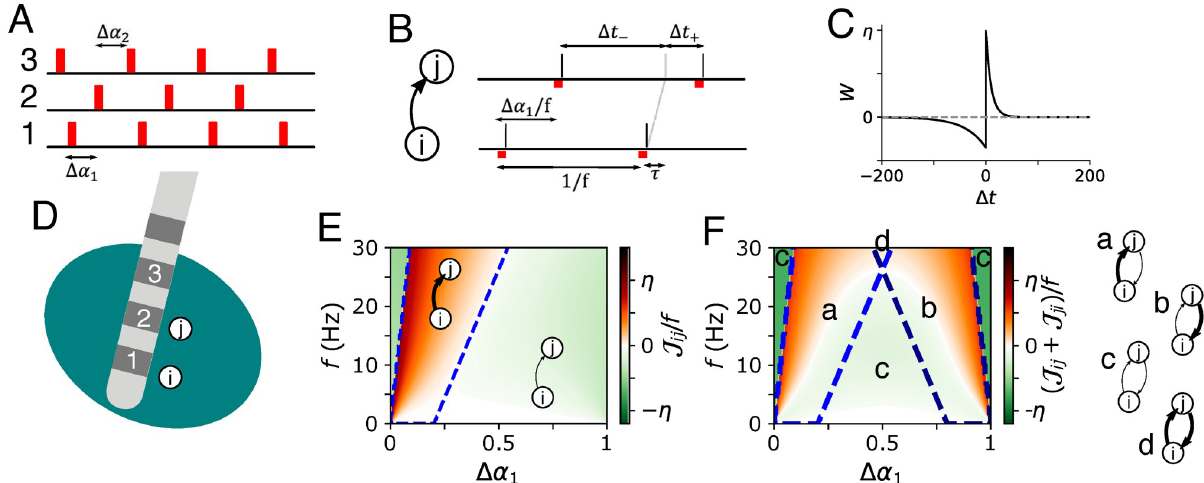
Fig 1. Reshaping of synaptic connectivity by PMCS. A: During PMCS, periodic stimulus trains (red) are delivered to multiple neuronal subpopulations (1,2,3) with phase shifts ( Δ α 1 , Δ α 2 ). D: Schematic of PMCS delivery using a multisite DBS electrode where phase-shifted stimulus trains are delivered to three contacts (1,2,3). Neurons are mostly affected by stimulus trains that are delivered to nearby stimulation contacts, neuron i by stimuli delivered to contact 1 and neuron j by stimuli delivered to contact 2. B: For illustration, in this figure we assume that neurons respond with a single spike (black vertical bar) of high fidelity to a stimulus (red). During stimulation, the spike train of the postsynaptic neuron, j , and that of the presynaptic neuron, i , become time shifted by Δ α 1 / f , where f is the stimulation frequency. Due to STDP, time lags, Δ t , between postsynaptic spikes and delayed presynaptic spike arrivals (gray) lead to weight updates, W , according to the STDP function (C, see Eq 10). Negative weight updates result from pairings of presynaptic spike arrivals with earlier postsynaptic spikes ( Δ t − < 0) and positive updates from pairings with later postsynaptic spikes ( Δ t + > 0). E: The sign of the overall weight update per inter-stimulus interval (ISI), J = f � W ð D t Þ þ W ð D t Þ , determines whether the synapse between (cid:0) þ ij neurons i and j is up-regulated (thick arrow) or down-regulated (thin arrow). F: If the neurons are bidirectionally coupled, PMCS may either induce effective unidirectional coupling (a,b), bidrectional coupling (d), or lead to decoupling (c). Blue dashed lines in panels E and F separate parameter regions with J > 0 from regions with J < 0 . Dark blue dashed lines separate corresponding regions for J . ij ij ji